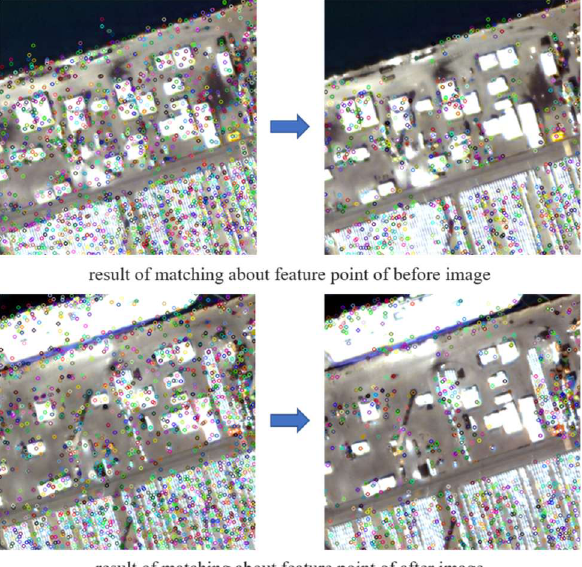
Figure 5. Result of eliminating feature point through